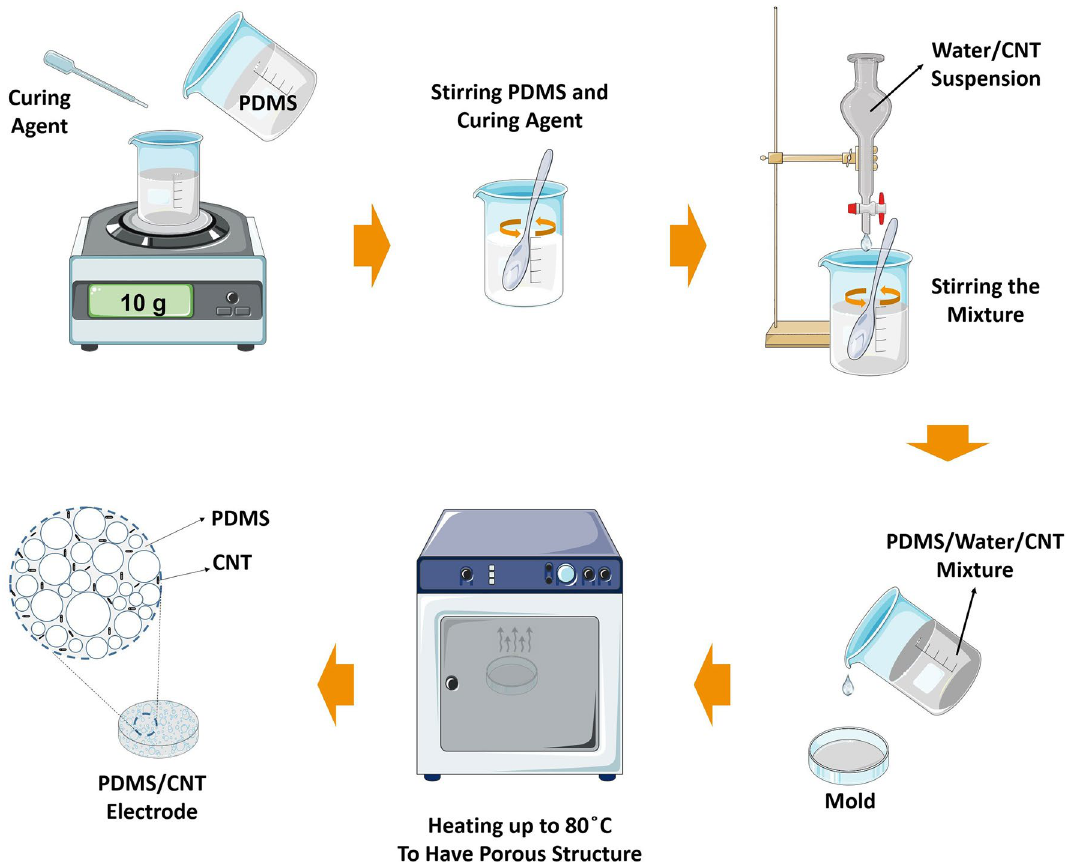
Figure 9. Schematic of the fabrication steps of PDMS/CNT porous